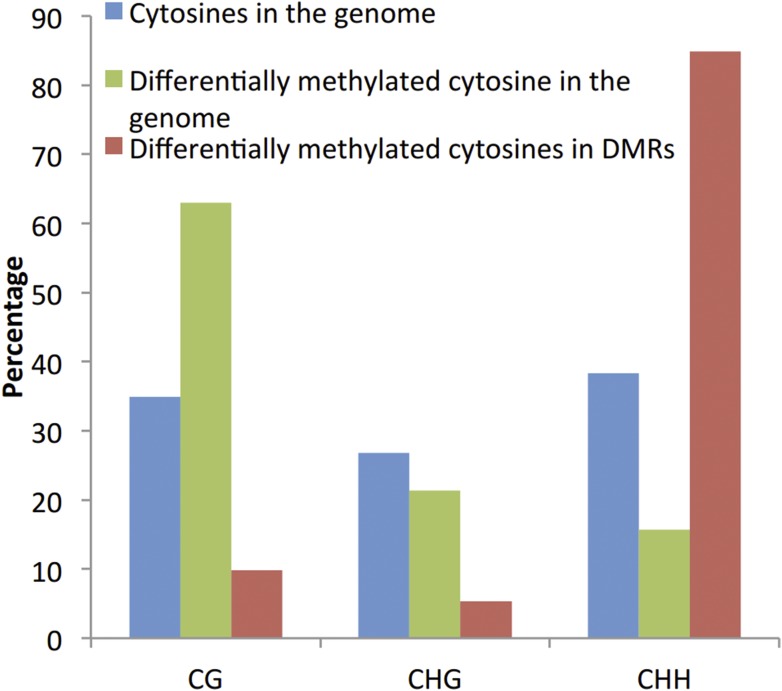
DOI:
http://dx.doi.org/10.7554/eLife.09343.036